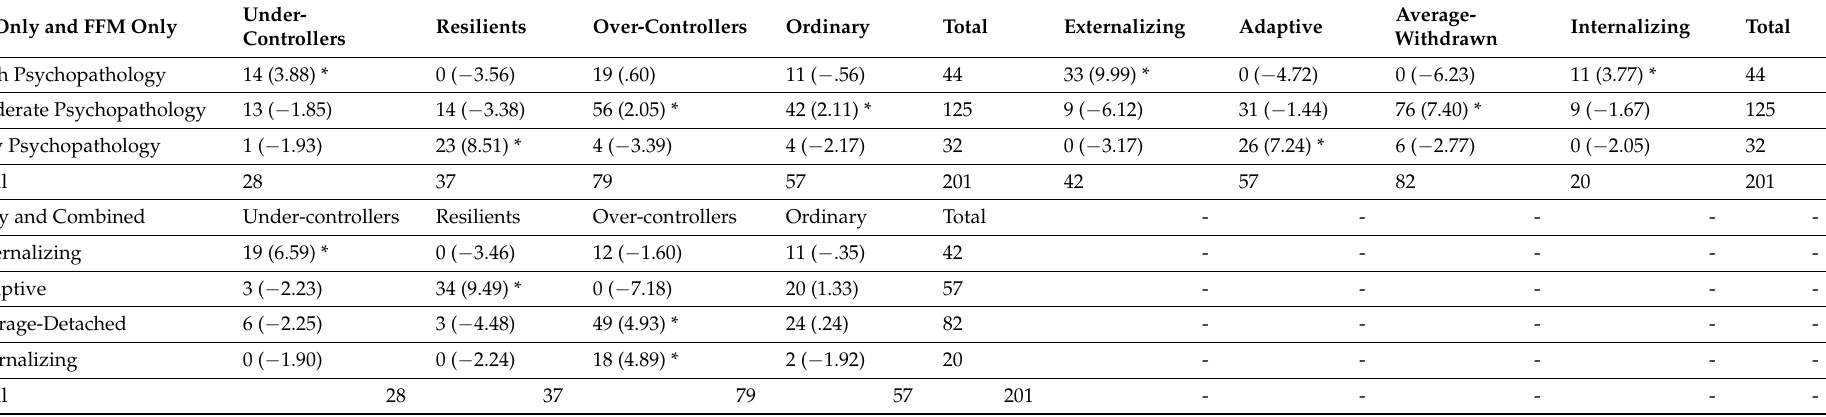
Table 6. Cross-Tabulation of FFM-Only and FFM–AMPD Combined Profiles, AMPD-Only and Combined Profiles, and FFM-Only and